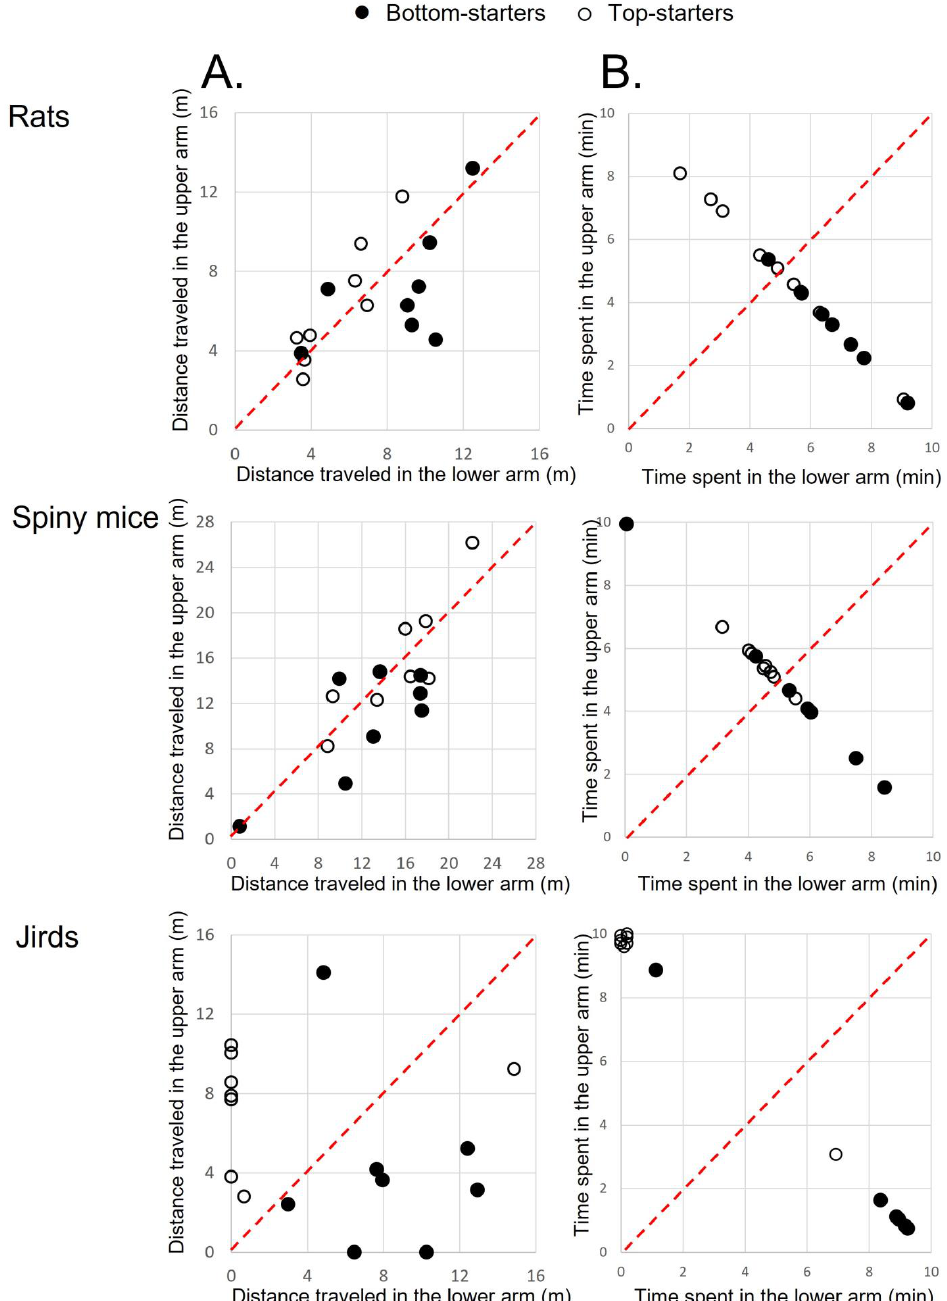
vs. the lower arm (abscissa) in the three species is depicted for top-starters and bottom starters. The dashed line represents a similar distance or time spent on both